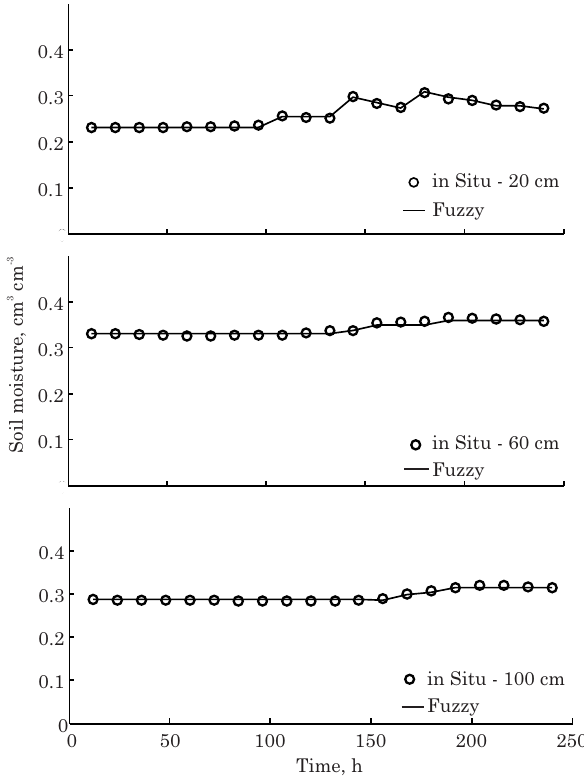
Figure 7. Comparison between the measured volumetric water content (symbols) and that calculated by the model based on fuzzy rules (solid lines) for three different depths.